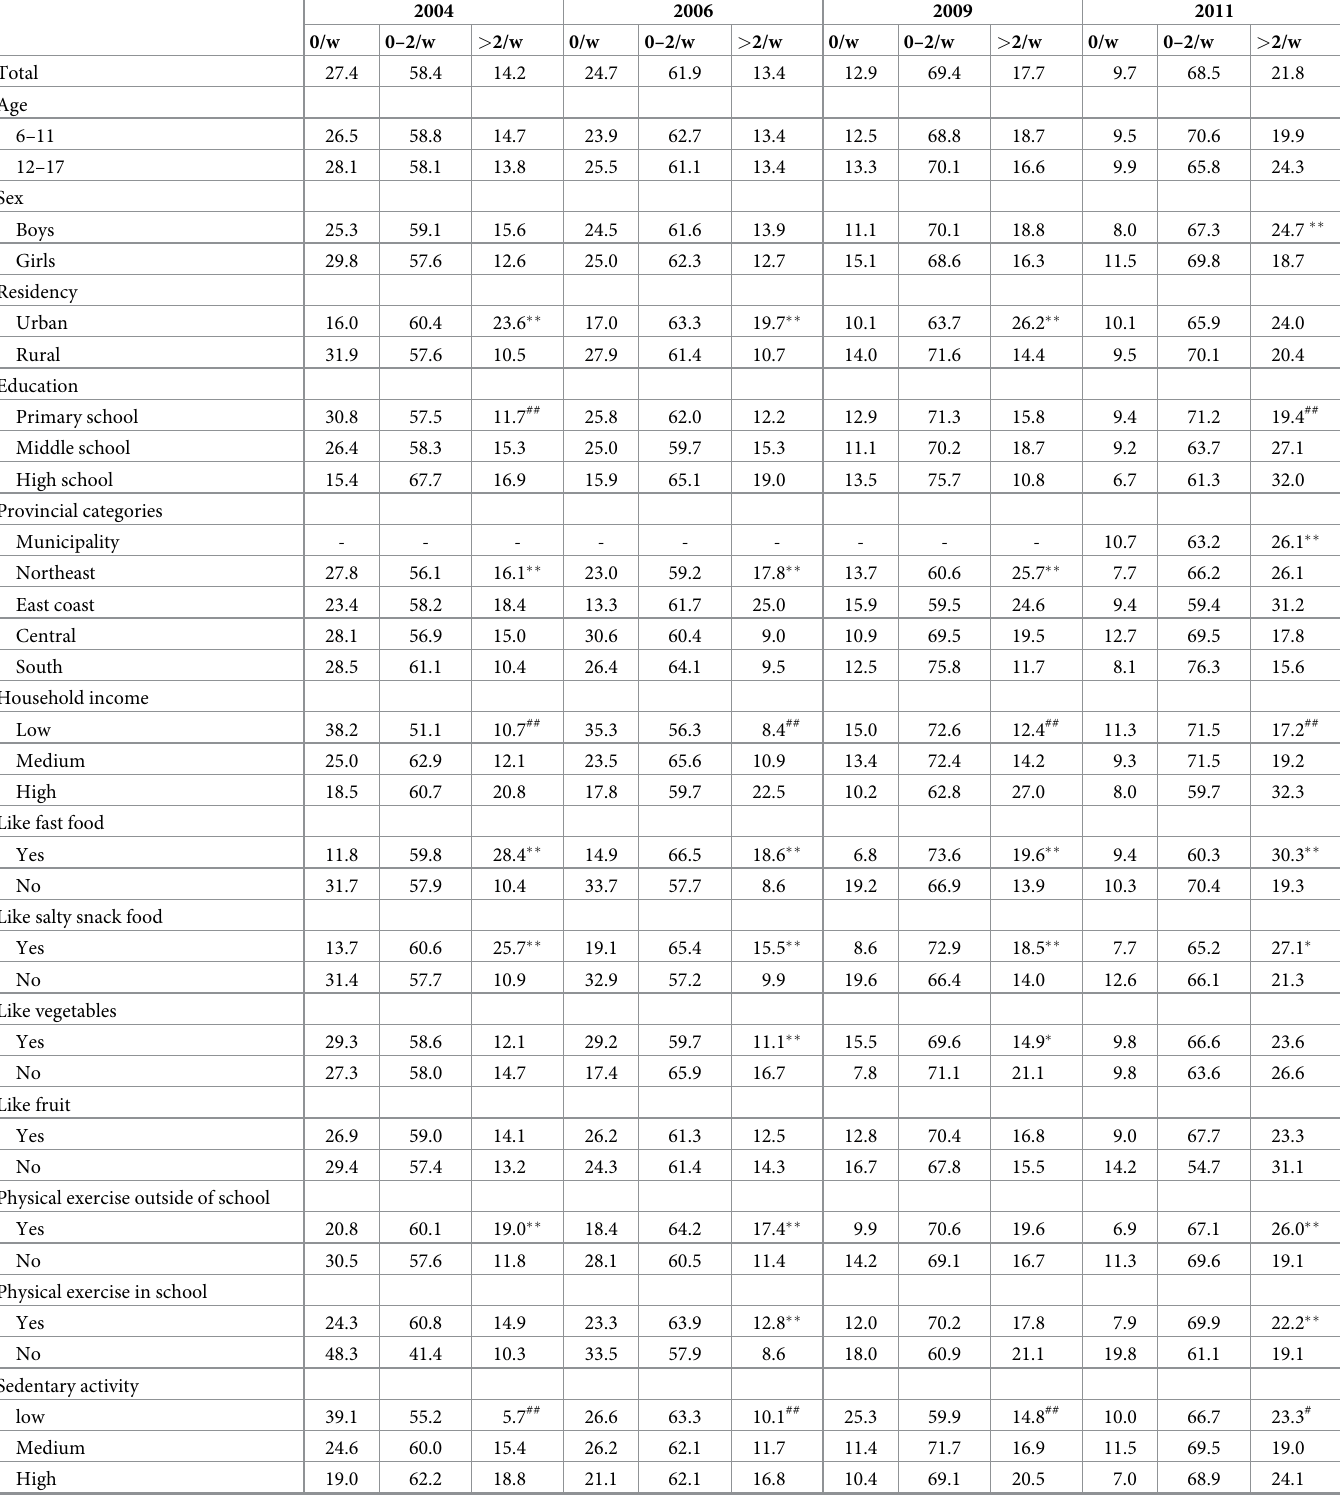
Table 2. Prevalence of SSB consumption in children in China from 2004 to 2011